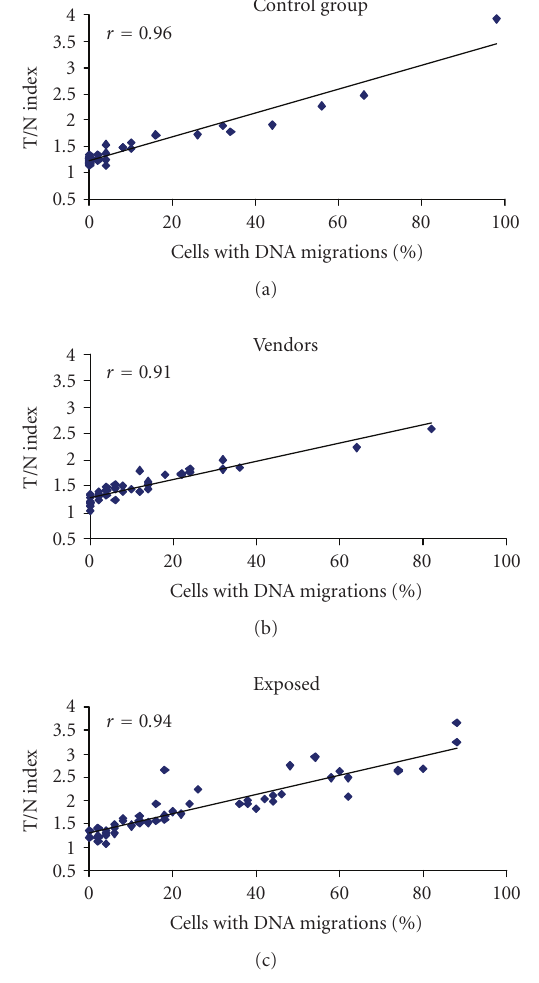
Figure 2: Correlation analyses of the T/N index and the percentage of damaged cells in the studied groups (P < . 001).